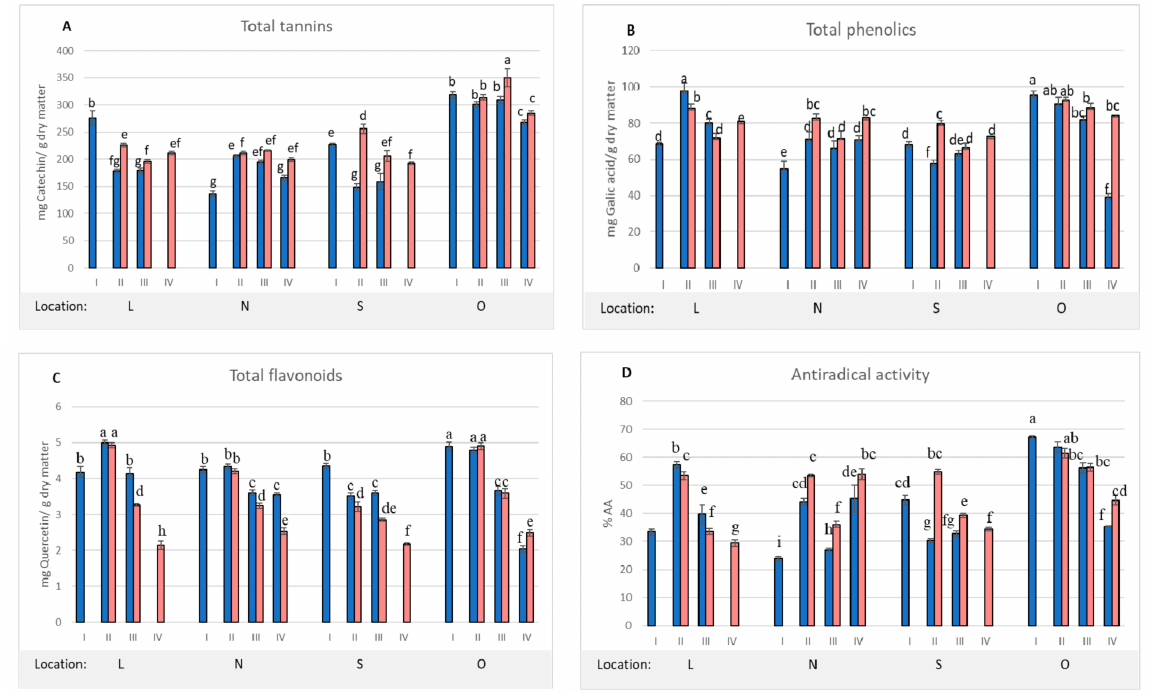
Figure 1. Changes in the content of secondary metabolites and antiradical activity of uninfested (blue) and infested (pink) chestnut leaves at four harvest dates. ( A ) Total tannins; ( B ) Total phenolics; ( C ) Total flavonoids; ( D ) Antiradical activity. The mean values denoted by different letters differ statistically significantly at p < 0.05.